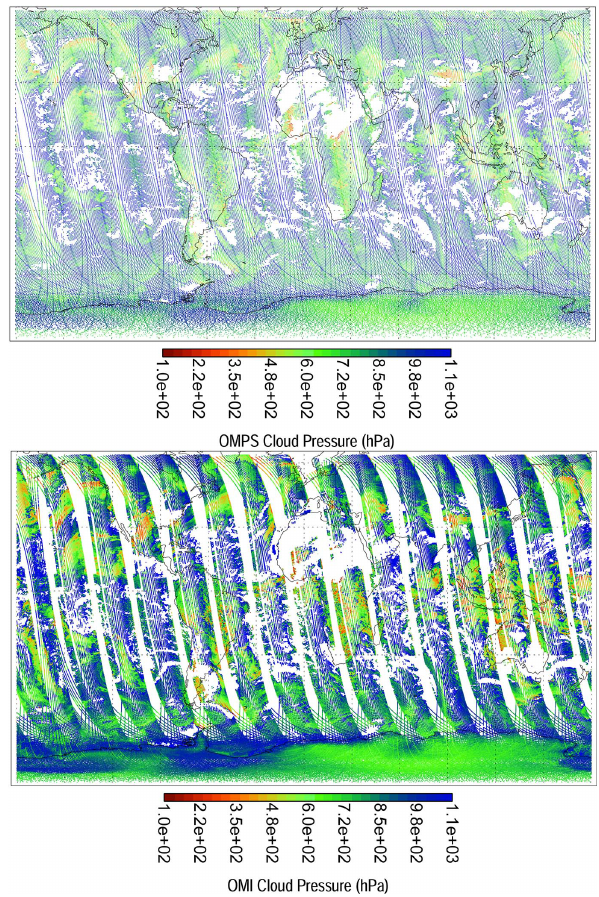
Figure 4. OCP (in hPa) from OMPS measurements (top) and OMI measurements (bottom) on 7 January 2013. Every pixel on the maps is represented by a color dot. OMI has 60 cross-track pixels while OMPS has 36 pixels. More pixels leads to a visual effect of the OMI map being brighter than the OMPS map.